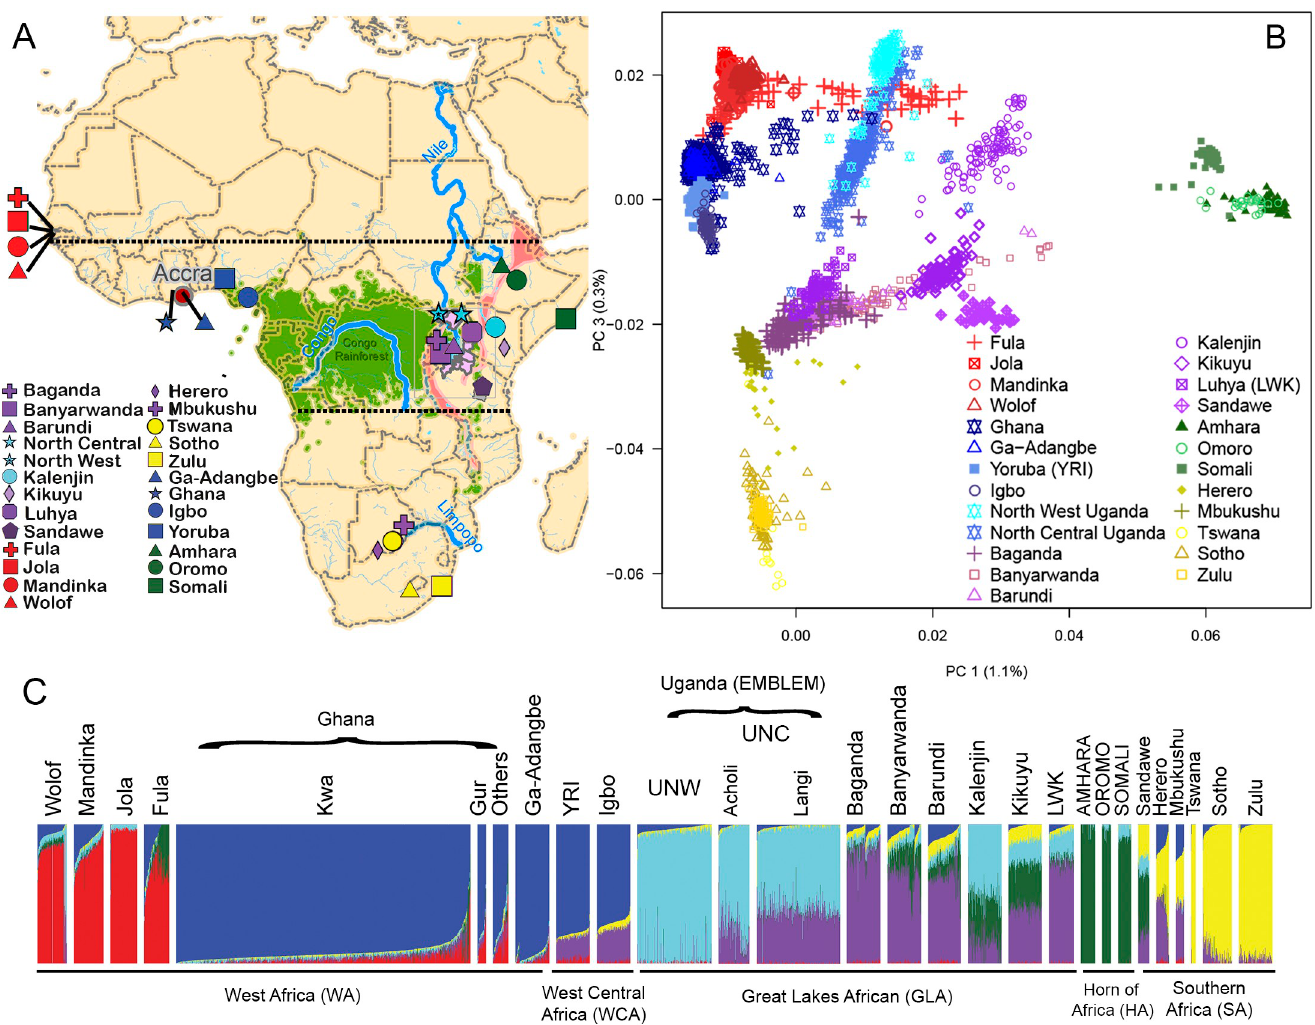
Fig 1. Populations studied in relation to major geographical barriers and analyses of population structure based on genotype data. (A) Map of Africa showing the geographical origin of the Pan-African populations used in the study comprising 22 populations from previous studies and three new populations in Ghana and the Uganda EMBLEM study (S1 Table). Horizontal dotted lines are the geographical extent of the endemic Burkitt lymphoma (eBL) belt (see S1 Fig and S1 Table for detailed information on Pan-African populations in the eBL belt). The map highlights major geographical features, such as the Congo rainforest (light green), major rivers and lakes, and the East and West African Rift valley systems (pink) that may have shaped migratory routes or constituted barriers to gene flow. (B) Principal Component Analysis (PCA) based on analysis of the genome-wide dataset of Uganda and Ghana integrated with 22 other pan-African populations. For better visualization, open symbols are used for the PCA plot and solid symbols are used in the map. The axes of the plot show the first and third principal components (See S10 Fig for other principal components). The PCA was repeated using similar number of individuals for each studied population (S9 Fig). (C) ADMIXTURE plot showing ancestry clusters in 28 populations from Africa (details in S1, S1A and S1B Table). The populations are listed left to right based on their geographical location in Africa from West to East and North to South. The colors represent different ancestral clusters, with K = 6 being the most likely number of clusters on admixture analysis (See S4 Fig). This ADMIXTURE analysis was repeated using similar number of individuals for each studied population (S6 Fig).